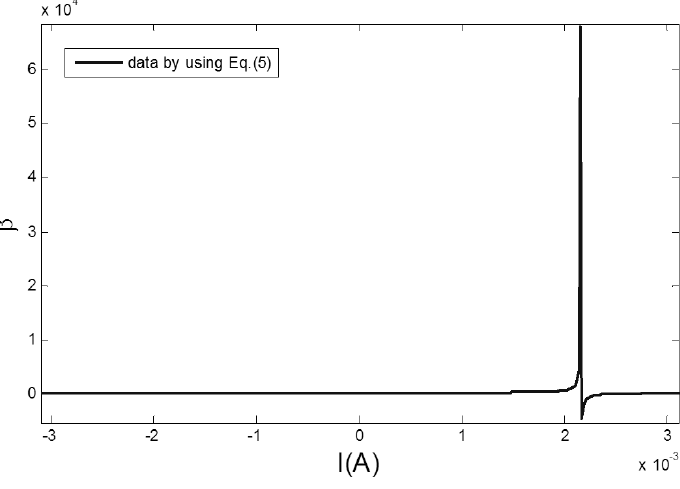
Figure 4. The actual changing curve of the permeability parameter 